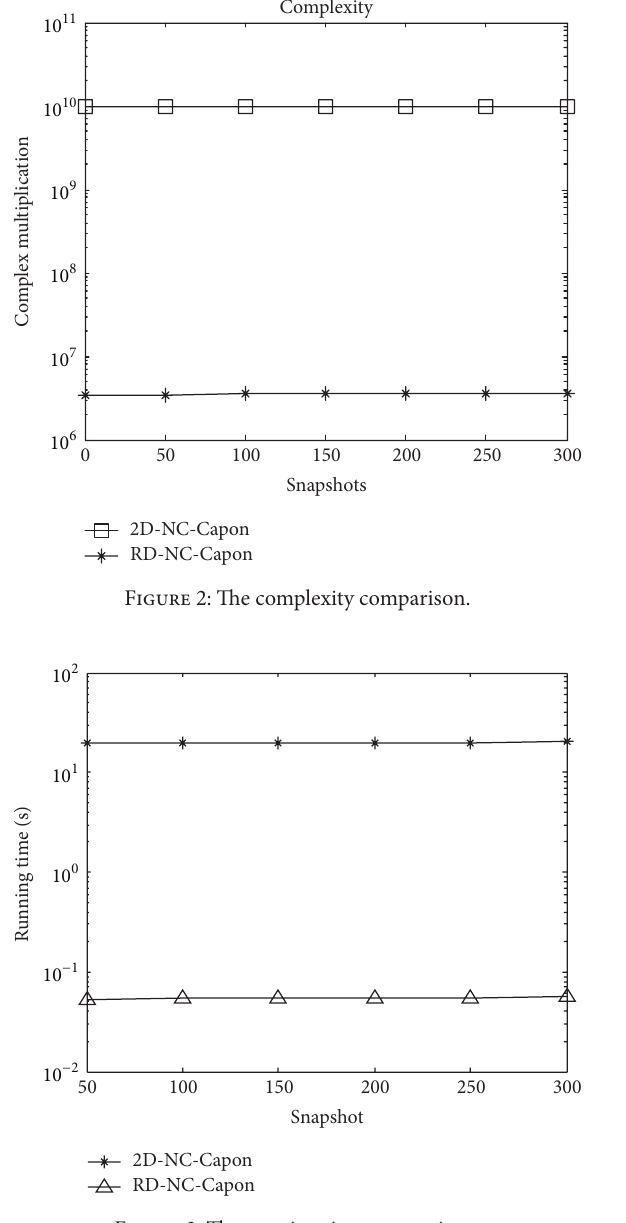
Figure 3: The running time